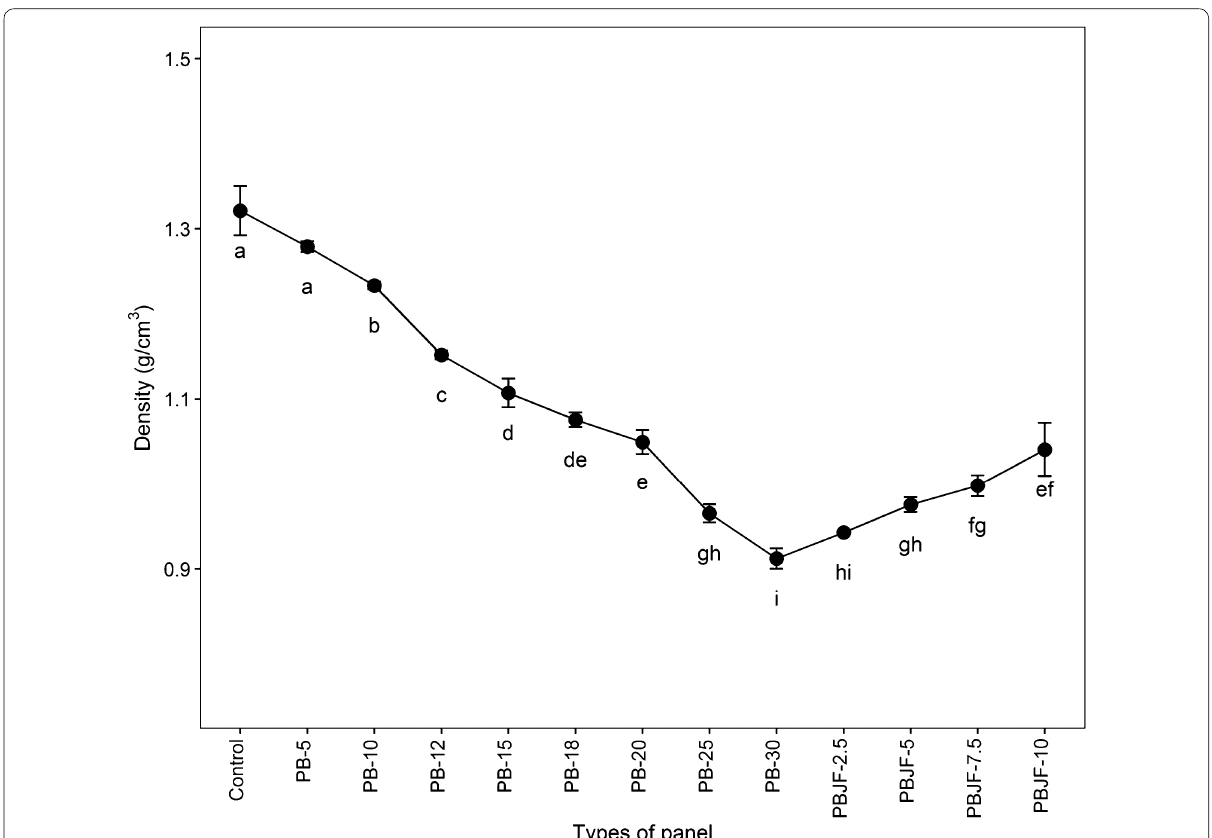
Fig. 1 Density variation for different types of CBCs produced using different raw materials. Different letters below each point indicate statistically significant differences among groups ( p <